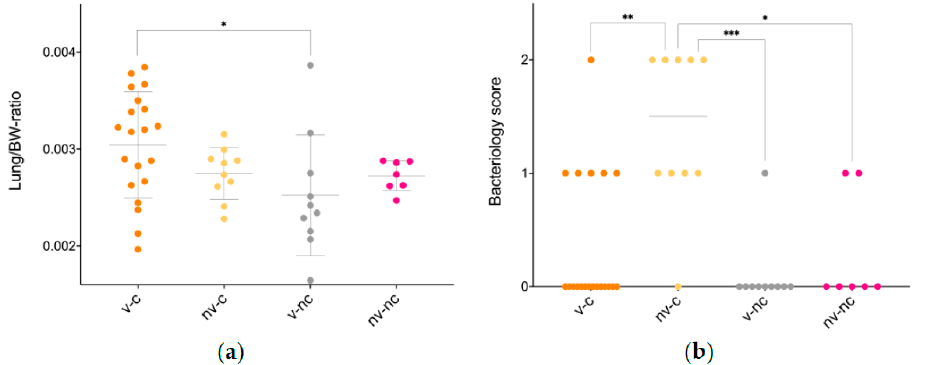
Figure 1. Lung/BW-ratio ( a ) and lung bacteriology ( b ). The data are presented with mean and SD or the median as appropriate, and ( a ) was analysed using a one-way ANOVA and a Tukey’s multiple comparisons test, whilst ( b ) was analysed using a Kruskal-Wallis test and Dunn’s multiple comparison test. * p < 0.05, ** p < 0.01, *** p < 0.001. Abbreviations: BW, bodyweight; nv-c, not vaccinated-challenged; nv-nc, not vaccinated-not challenged; v-nc, vaccinated-not challenged; v-c, vaccinated-challenged.